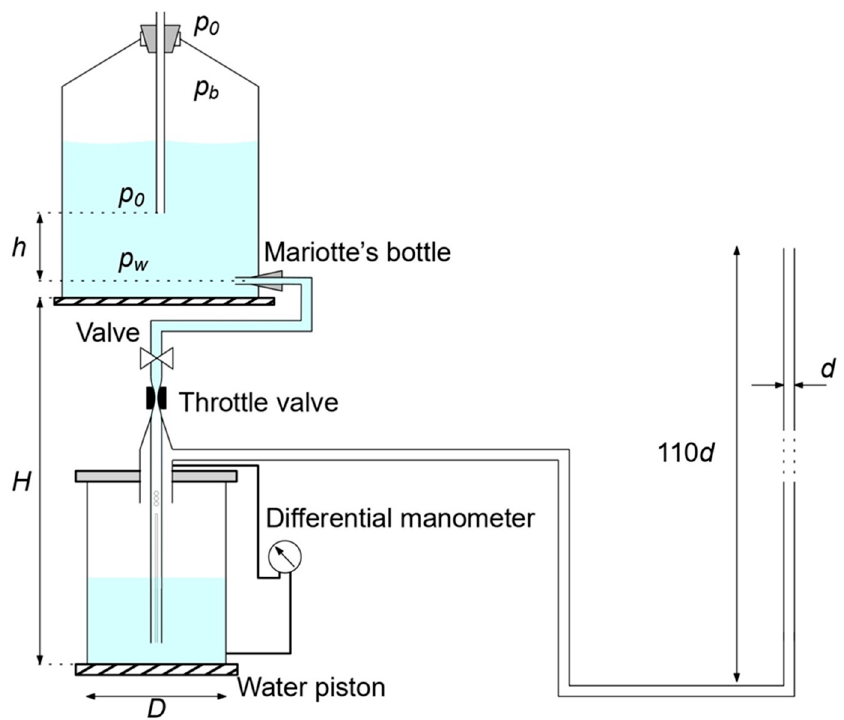
Figure 1. Measurement stand: p 0 —atmospheric pressure, p b —pressure above the water surface, p w —pressure at the bottom of the piston, h —distance between Mariotte’s bottle outflow level and the end of air supply pipe, H —distance between bottom of water piston and bottom of Mariotte’s bottle, D —diameter of water piston, d—diameter of outlet pipe.